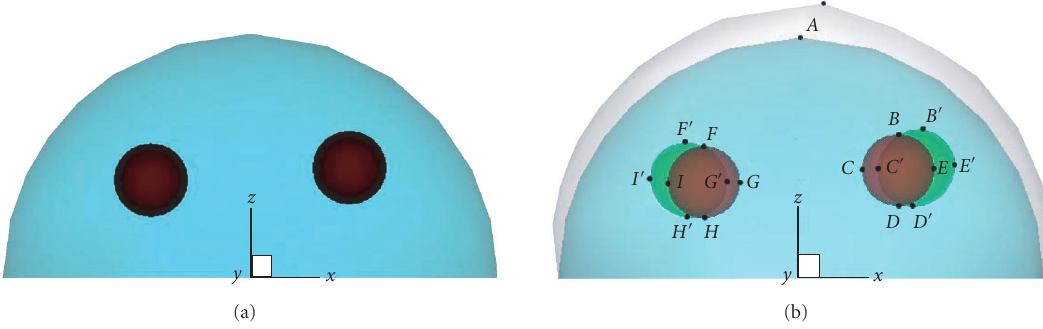
Figure 5: Mammography projections for Phantom II under Loading 1. Projections are made in direction 1. (a) Undeformed projection; (b) deformed projection overlaps on undeformed projection. In the projections, vertexes A ∼ I in undeformed projection move to A (cid:3) ∼ I (cid:3) in deformed projection,